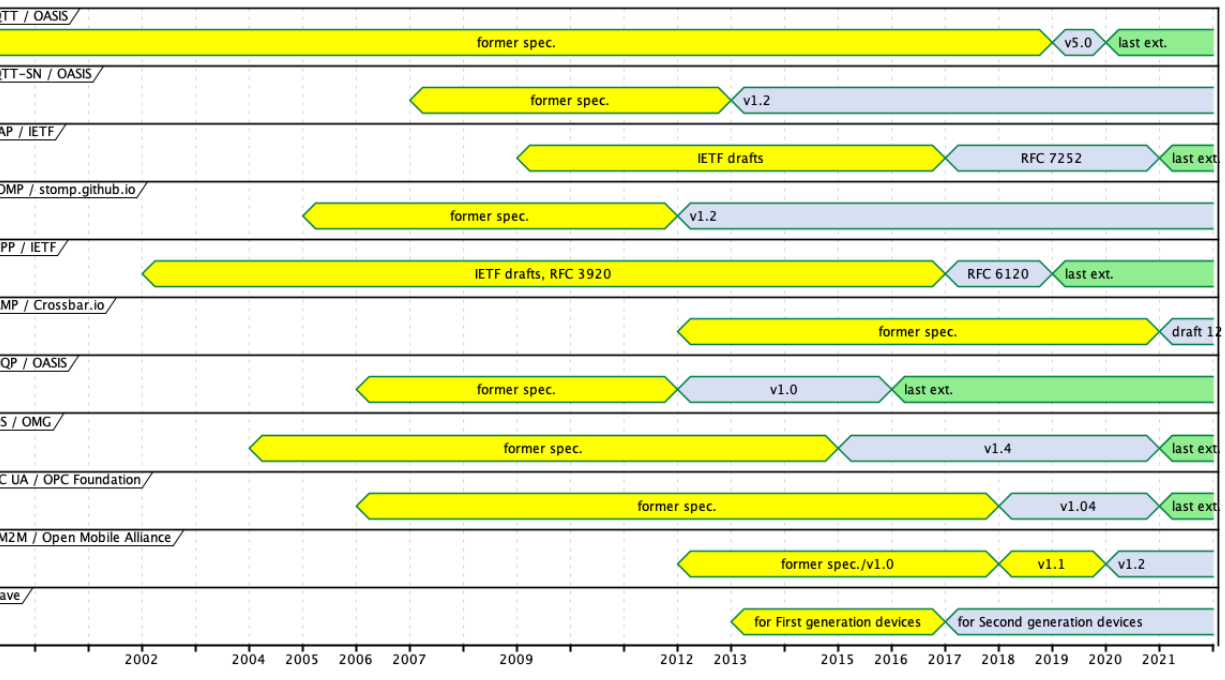
Figure 2. Volume of the protocol documentation in the number of pages.